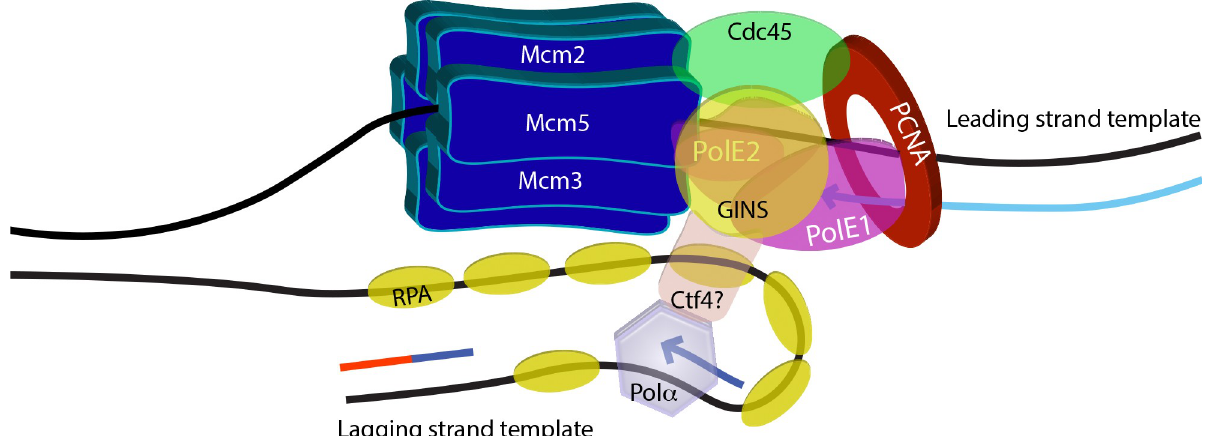
Fig 8. The role of Cdc45-PCNA interaction at the replication fork. The active replisome on the leading strand template includes several proteins such as the Cdc45-MCM-GINS complex, DNA pol ε , and PCNA. Here, the heterotetrameric GINS is represented as a single entity. DNA pol ε is depicted with only two subunits: PolE1 (bi-lobed) and PolE2, as the other two subunits have not been identified in trypanosomatids. No Ctf4 has yet been identified in trypanosomatids. The interaction of Cdc45 with PCNA, the sliding clamp processivity factor of the replicative polymerases, may further stabilize the polymerase on the advancing replisome machinery, thus enhancing the efficiency of